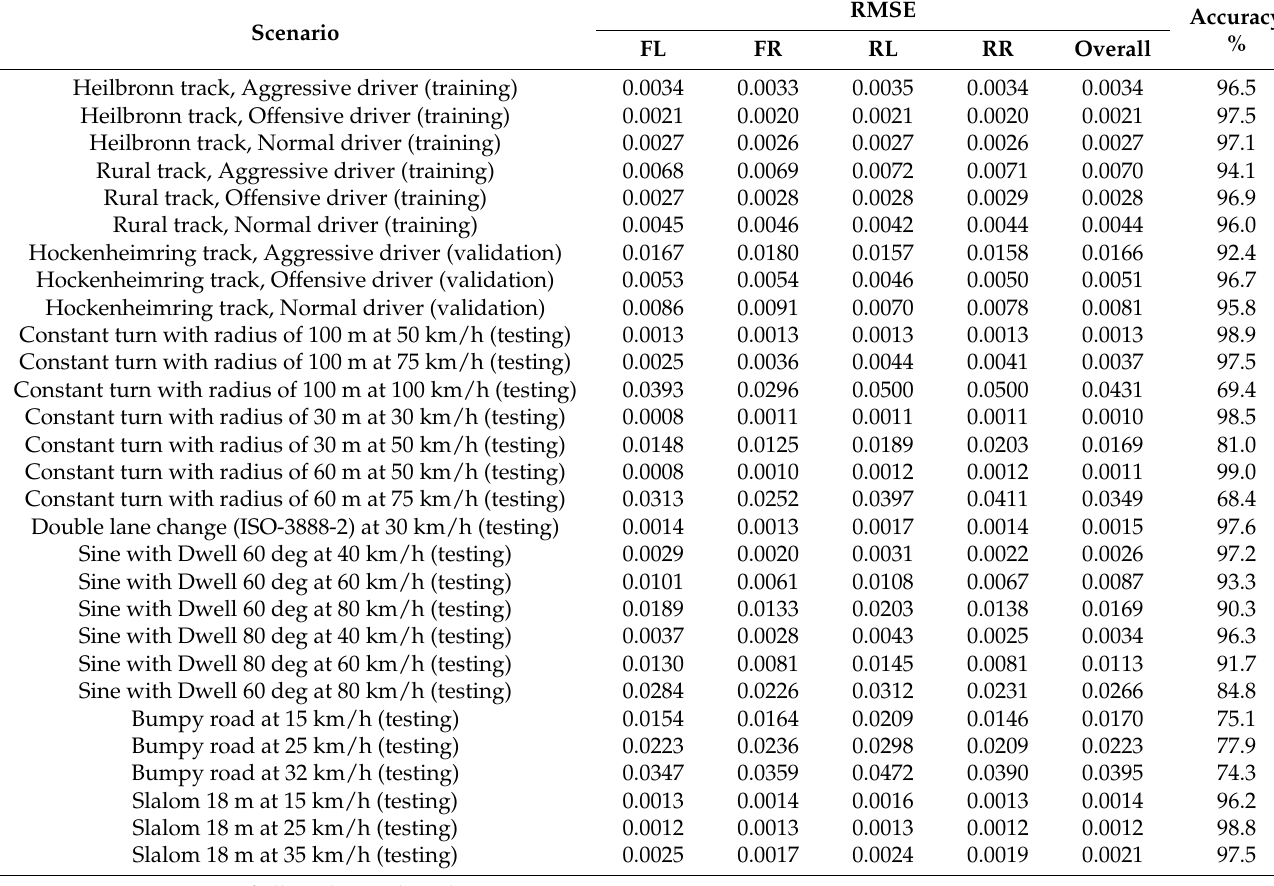
Table 4. RMSE achieved in various training, validation and testing scenarios for each wheel and overall.